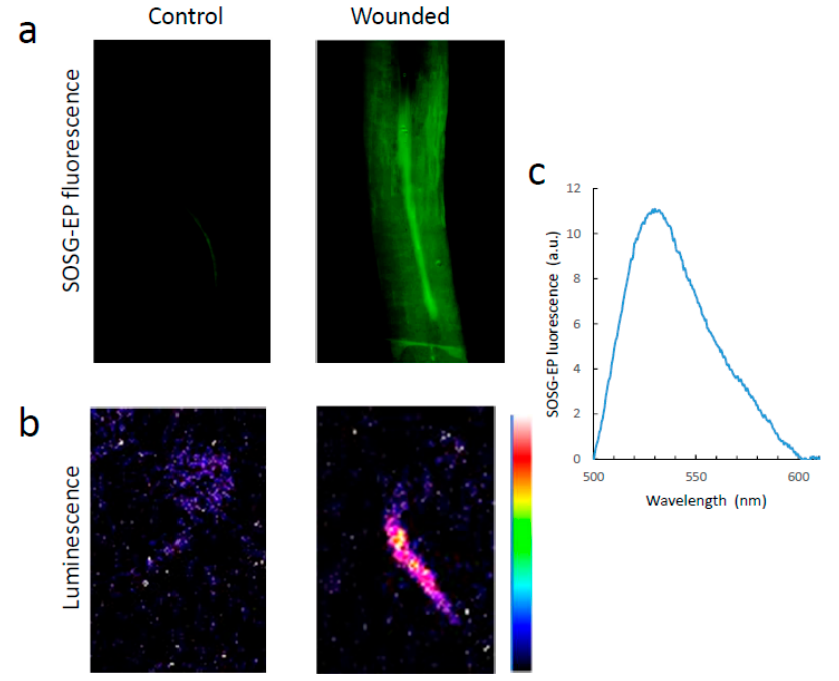
Figure 7. Singlet oxygen in wounded pea roots. ( a ) SOSG-EP fluorescence in a wounded pea root. ( b ) SCL image of the wound shown in panel ( a ). ( c ) Spectrum of the fluorescence emitted by wounded roots pre-treated with SOSG.